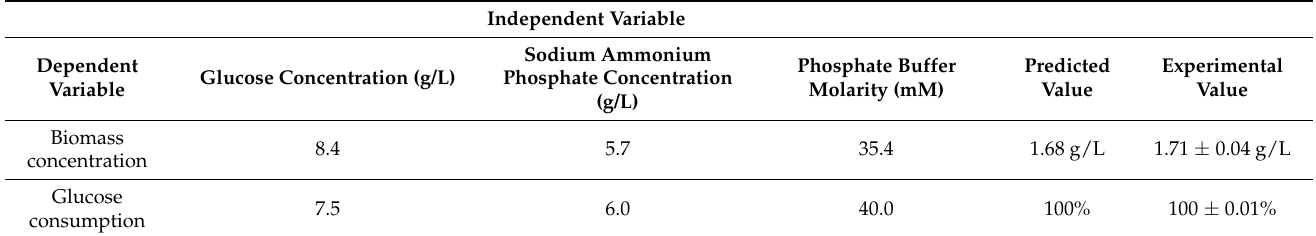
Table 3. Predicted and experimentally verified values of biomass concentration and glucose con- sumption under optimal production